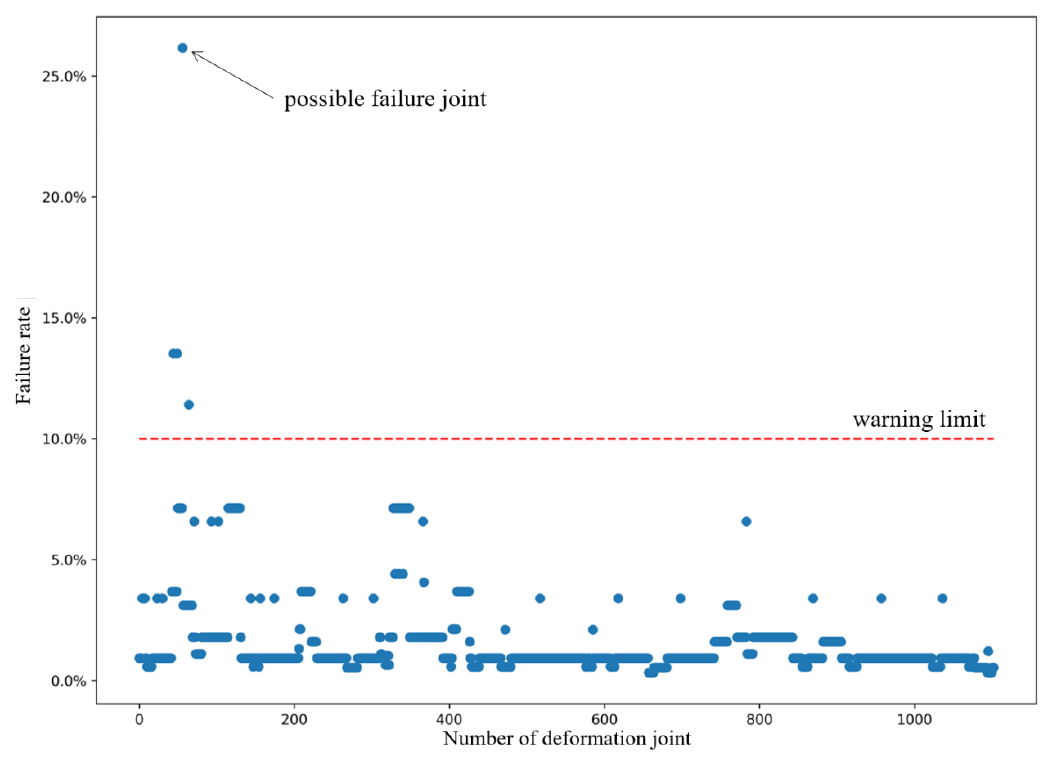
Figure 9. Estimated failure rates of deformation joints in the case study.